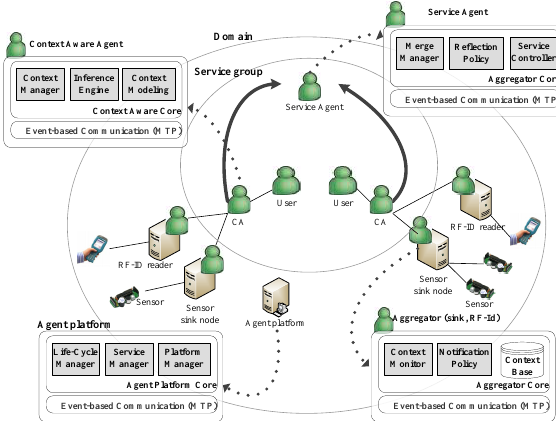
Fig. 1. The structure of the proposed context-aware